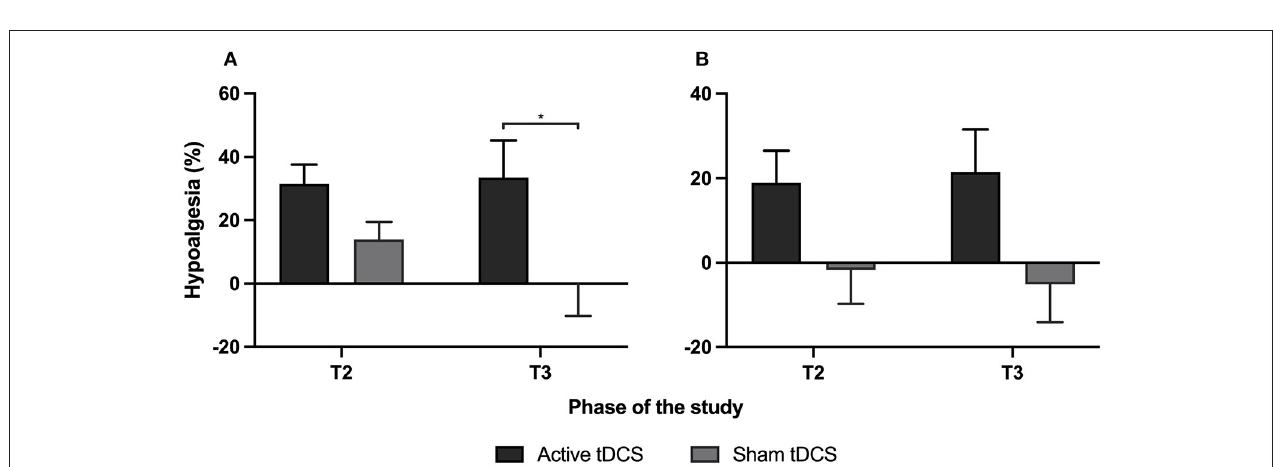
FIGURE 3 | Percentages of hypoalgesia are calculated with (A) the daily average pain and (B) the daily maximal pain measured using the pain logbook. For each graph, the first two columns represent hypoalgesia during the week of tDCS treatments (comparing T2 to T1) and the second two columns represent hypoalgesia during the 7 days of follow-up (comparing T3 to T1). Each column represents mean ± SEM. *Indicates statistically significant ( p <